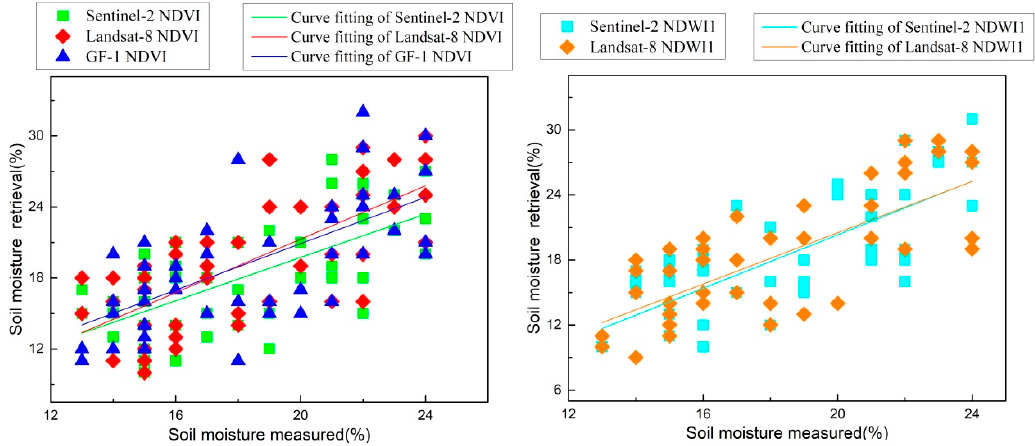
12 of 16 Figure 5. Ratio of bare soil contribution to total scattering (  (cid:3046)(cid:3042)(cid:3036)(cid:3039)(cid:2868) /  (cid:3047)(cid:3042)(cid:3047)(cid:3028)(cid:3039)(cid:2868) ) for all sites using seven indices. Each graph fits a curve through the regression equation to show the trend. 4.3. Effect of Indices from Different Optical Data on Accuracy of Soil Moisture Retrieval